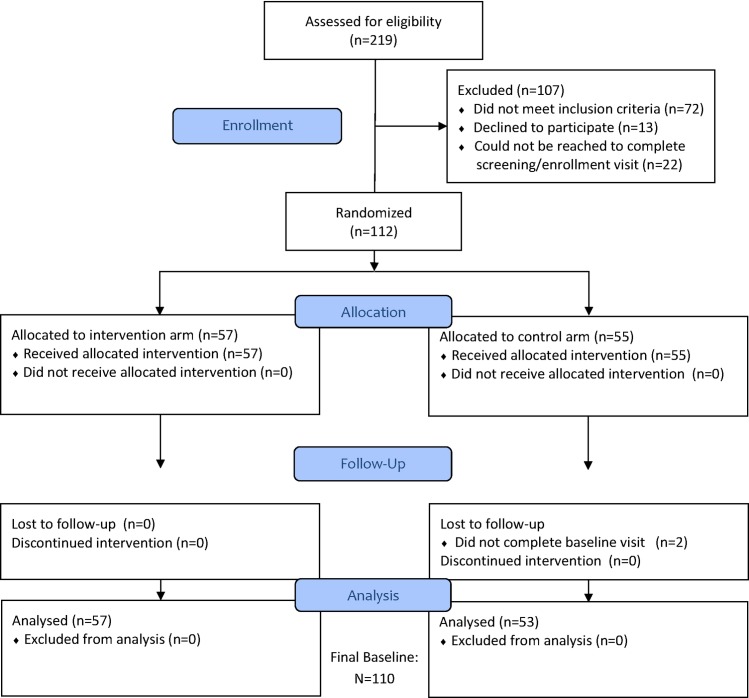
CONSORT Diagram.